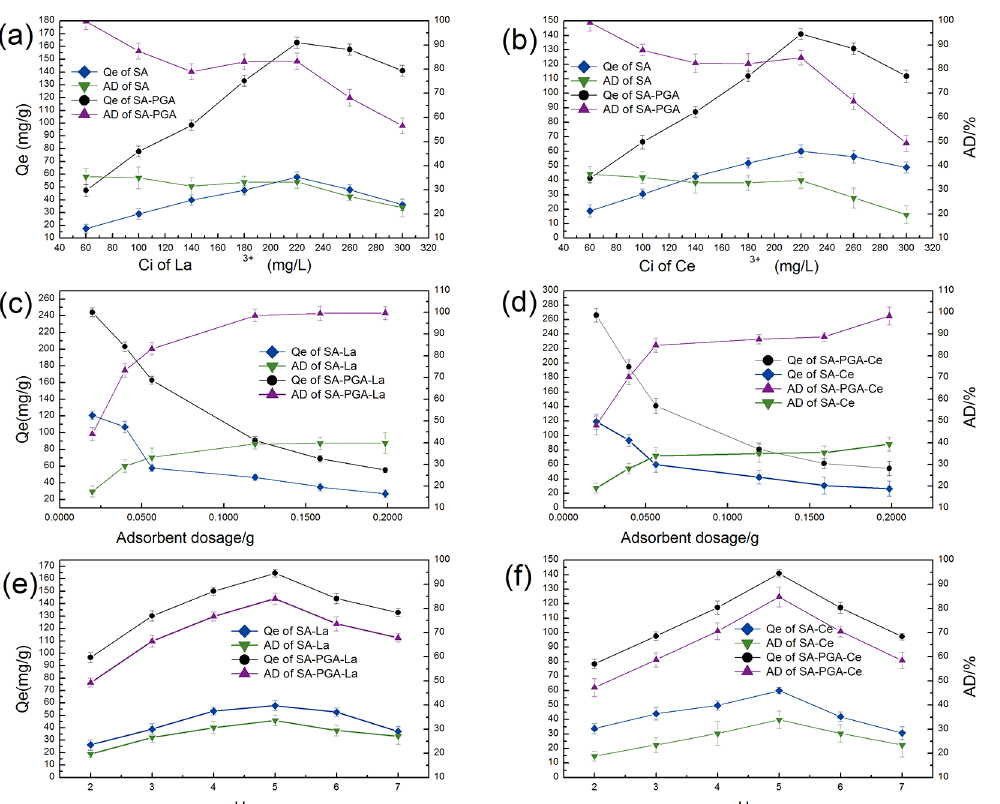
Fig 1. Effects of the initial concentration of REEs, adsorbent dosage, and pH of solution on the adsorption by gel particles (Adsorption conditions: temperature 30°C; 150 rpm; and 3h adsorption time).